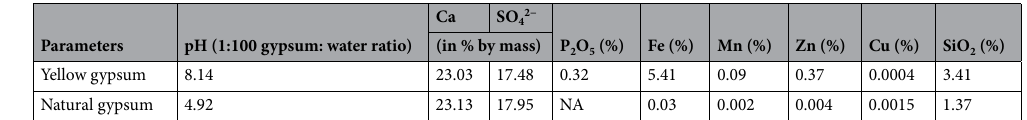
Table 2. Chemical composition of yellow gypsum and natural gypsum. NA—Not available. Each value represents the mean value of three replications.